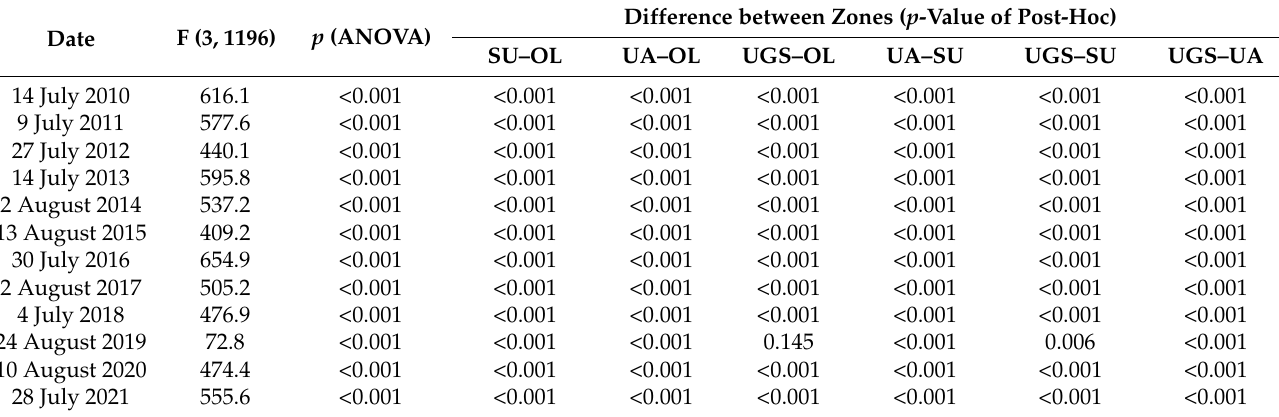
Table 4. A significance level of the F-test in one-way ANOVA and multiple comparisons of differences between pairs of zones in the territory using the Tukey HSD